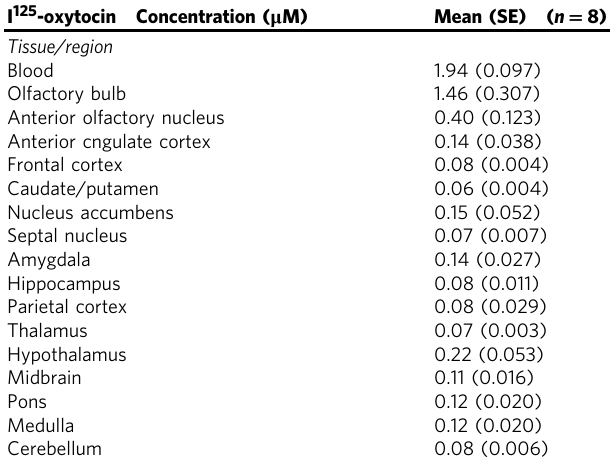
Table 1 Concentrations of I 125 -labeled oxytocin following intranasal administration I 125 -oxytocin Concentration ( μ M) Mean (SE) ( n = 8) Tissue/region